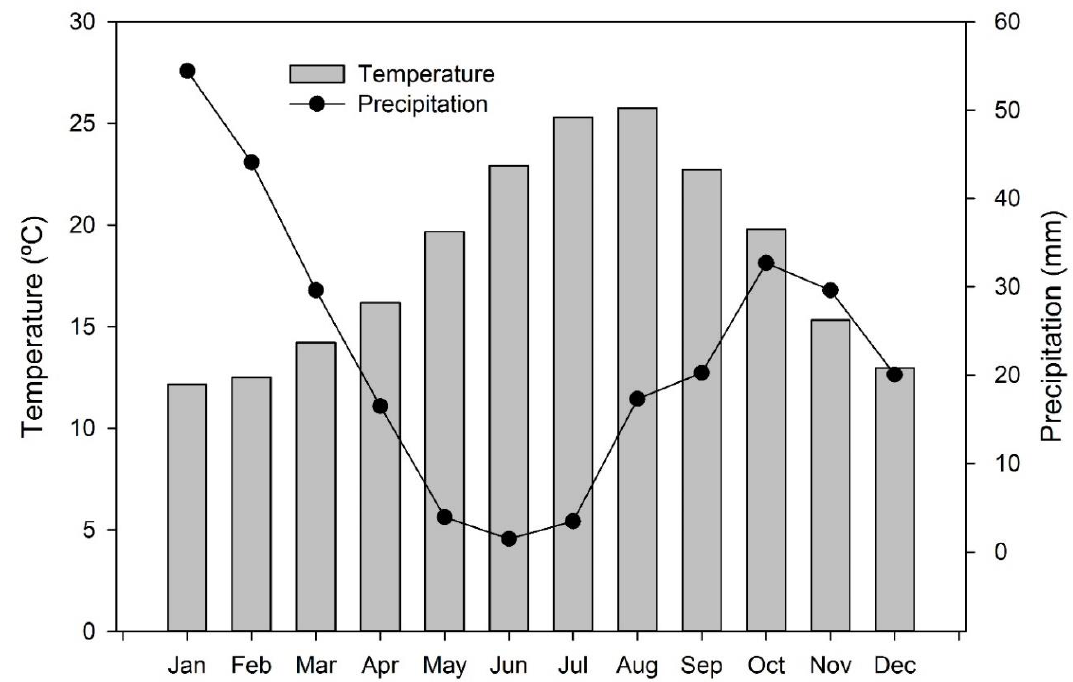
Figure 2. Average monthly temperature (line) and rainfall (bars) based on a 17-year period (2000–2016). Source: La Mojonera Agroclimactic Station (Junta de Andalucía).